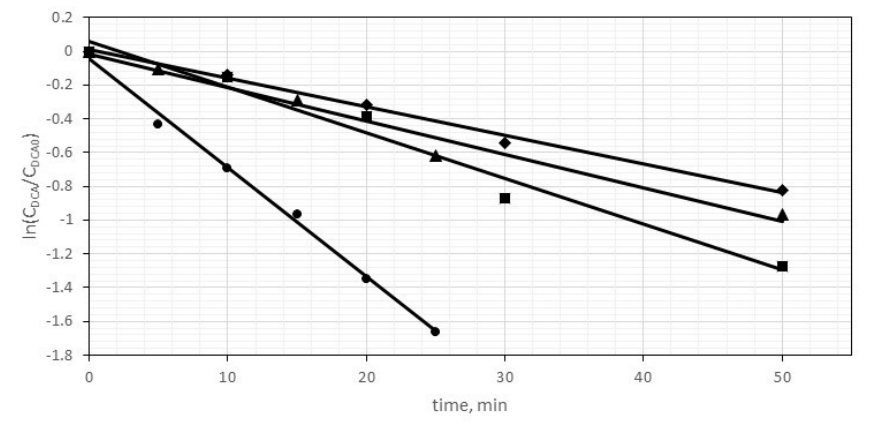
Figure 6. First-order kinetics for the photocatalytic oxidation of Dichloroacetic acid (DCA) (experi- mental data deduced from [21]). Initial DCA concentration, mgL − 1 : 5; 20; 50; 70.